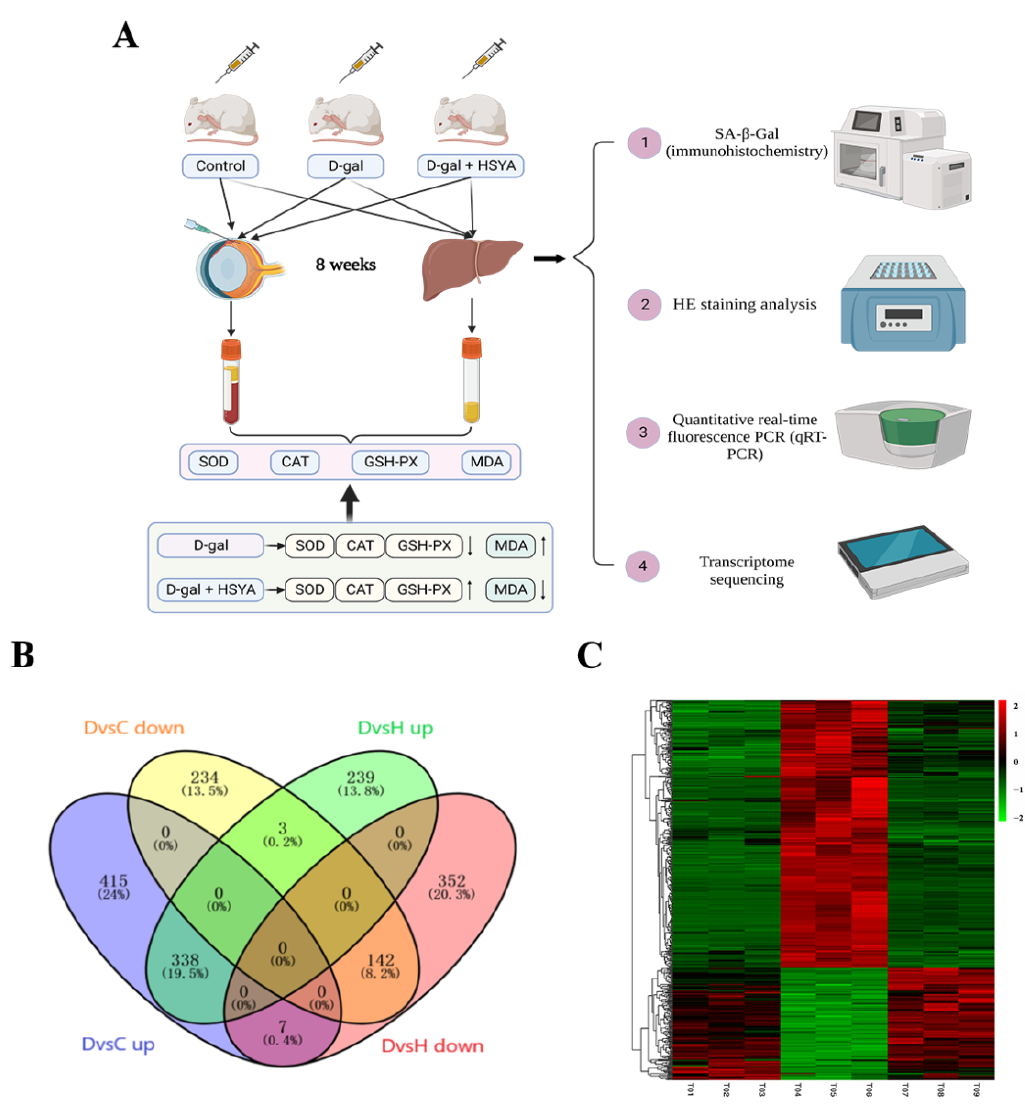
Figure 4. HSYA reversed the DEGs of D-gal-induced LA mice. ( A ) Protocol of the liver-aging model and treatment, as described in Materials and Methods. ( B ) Intersection of low-expressed DEGs (D-gal group vs. control group and D-gal group with HSYA vs. D-gal group), and intersection of highly expressed DEGs (D-gal group vs. control group and D-gal group with HSYA vs. D-gal group). C refers to the control group, D refers to the D-gal aging group, and H refers to the D-gal group with HSYA. ( C ) Heatmap analysis of low-expressed DEGs and highly expressed DEGs (total number of genes: 480).